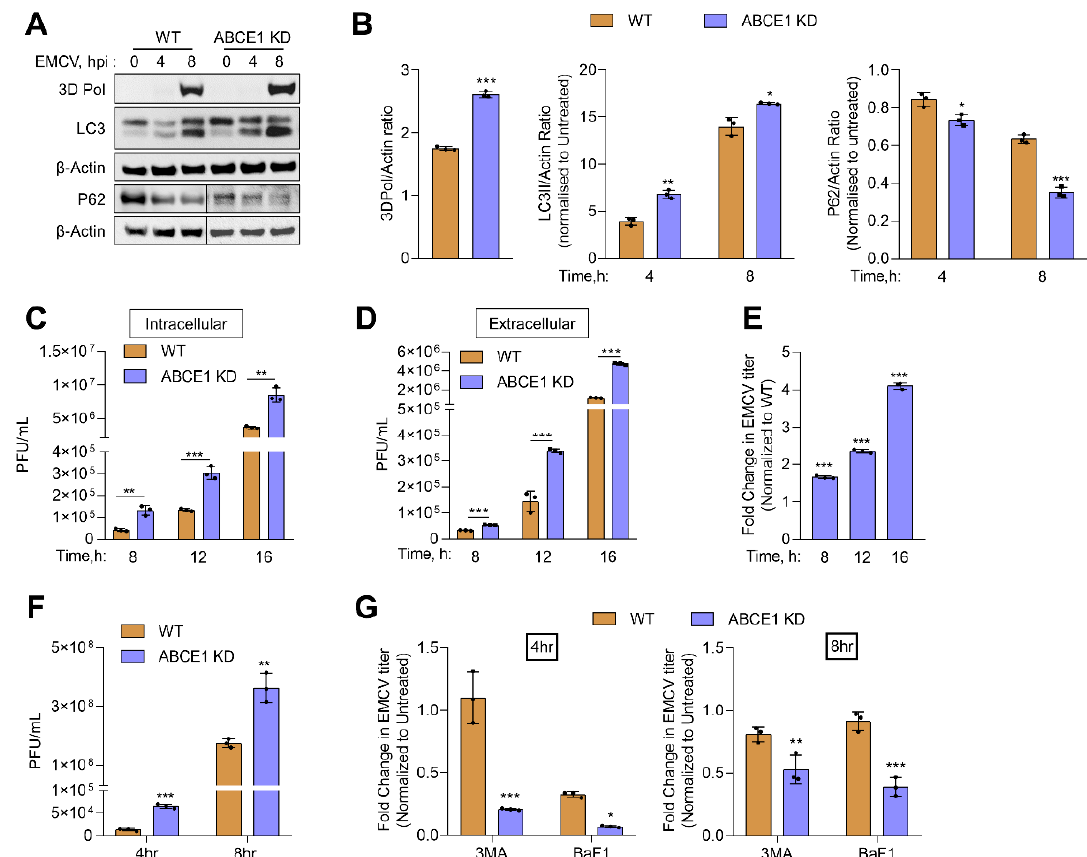
Figure 5. Effect of ABCE1 on autophagy during EMCV infection. HT1080 WT and ABCE1 KD cells were infected with EMCV (MOI of 1.0) and at indicated times ( A ) conversion of unconjugated LC3-I to lipidated LC3-II, degradation of p62, and accumulation of viral protein 3D Pol were monitored on immunoblots and normalized to β -actin levels. ( B ) The band intensity was calculated using Image J software, and the ratio of LC3-II/ β -actin, p62/ β -actin, or 3D Pol// β -actin was determined and the levels were compared to WT cells. ( C ) Intracellular and ( D ) extracellular titer of EMCV were determined by a plaque assay, and ( E ) the fold change in EMCV titers in supernatants of ABCE1 KD cells was compared to WT cells. Results are representative of three independent experiments. ( F ) EMCV titers in WT and ABCE1 KD cells 4 h or 8 h post infection. ( G ) WT and ABCE1 KD cells were left untreated or were pretreated with 3-MA (5 mM) or bafilomycin A1 (100 nM) 1 h prior to infection with EMCV (MOI of 1.0), and viral titers in the supernatant were determined by a plaque assay. The fold change in the viral yield in WT and ABCE1 KD cells treated with either 3-MA or bafilomycin A1 was compared to untreated samples. Data represent mean ± SD performed in triplicate. WT: wild-type; * p < 0.05; ** p < 0.01; *** p < 0.001.